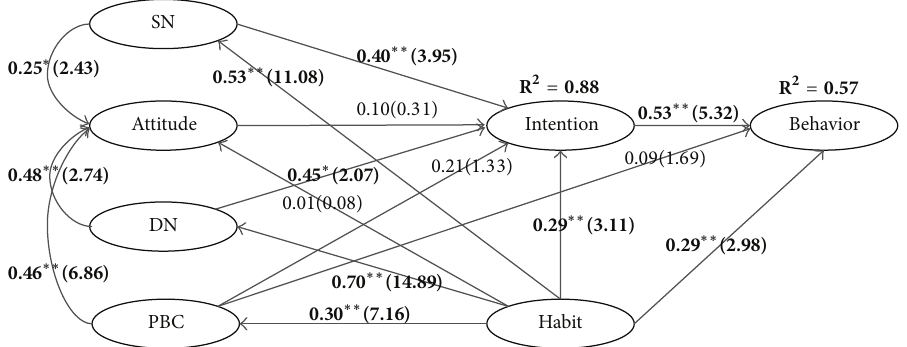
Figure 7: Standardized coefficients between the latent factors using traditional train.